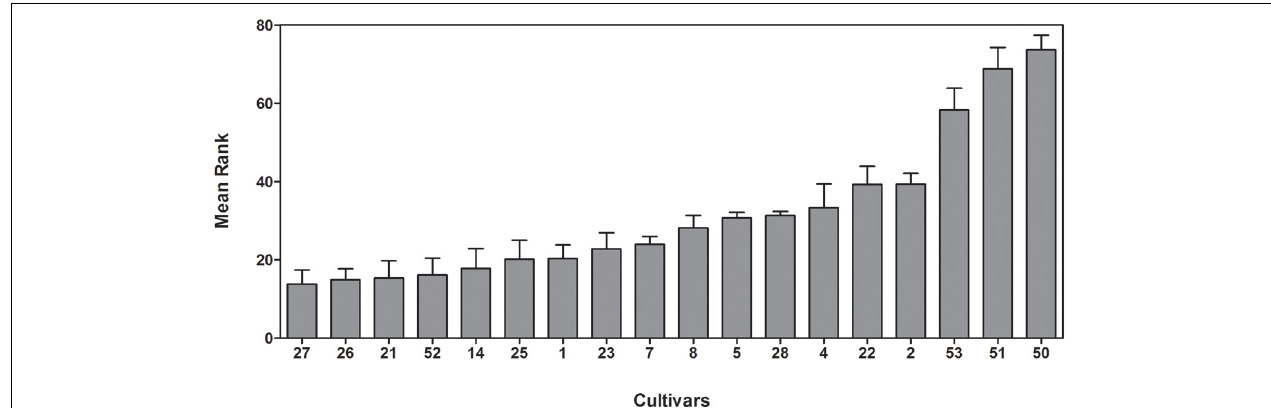
FIGURE 1 | Classification of 18 rice cultivars after 13 days at 100mM NaCl in hydroponic culture. Scores were ranked and the average rank of three independent experiments is shown with standard errors. Cultivars are sorted from the most tolerant to the most sensitive from left to right.